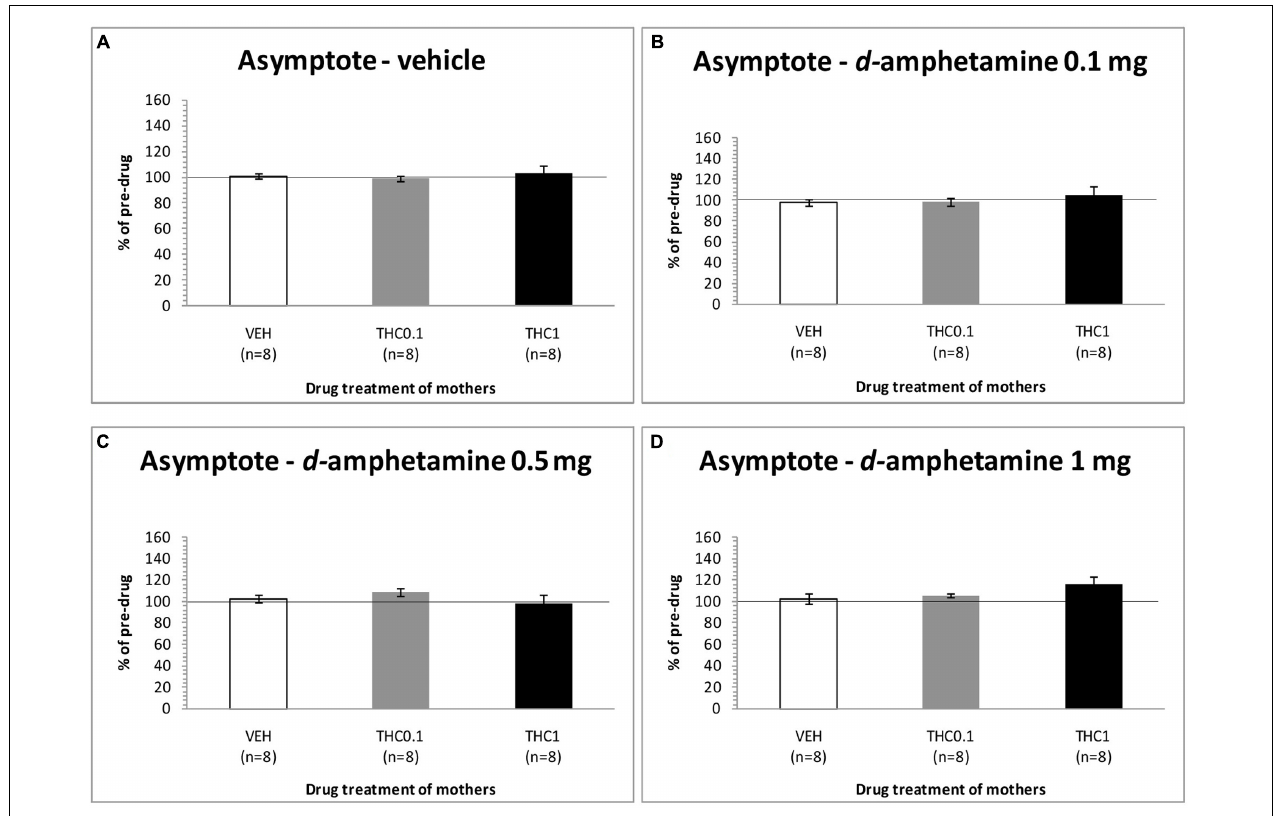
FIGURE 5 | Changes in asymptotic rate of responding in F1 animals, expressed as percentage of predrug value, following acute i.p. administration of 0 mg/kg (A) , 0.1 mg/kg (B) , 0.5 mg/kg (C) , and 1 mg/kg (D) of d -amphetamine. Horizontal axes represent the three groups of F1